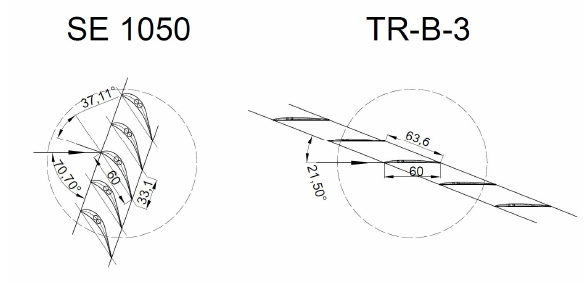
Fig. 5. Drawings of profile cascades. a) SE 1050 , b) TR B-3.